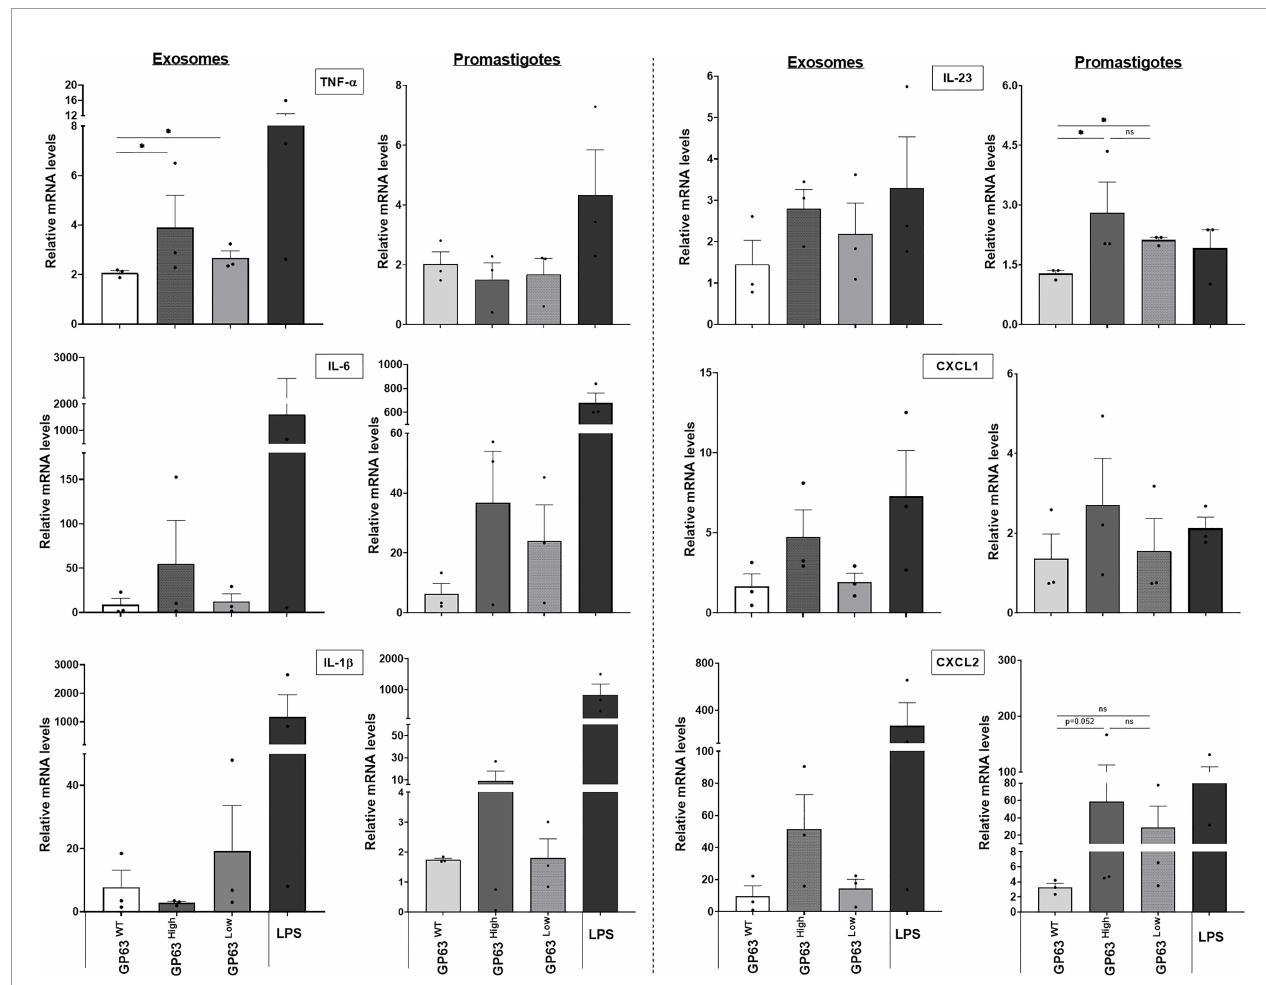
FIGURE 4 | Impact of various Leishmania amazonensis species and their derived EVs stimulation on the in fl ammatory response gene expression of innate immunity cells. Analysis by qrt-pcr of key in fl ammatory cytokines and chemokines of immortalized bone marrow-derived macrophages (B10Rs), after stimulation for 4 hours with either the 3 different populations of Leishmania amazonensis -derived EVs or the 3 strains of Leishmania amazonensis live parasites; One-way ANOVA by Kruskal-Wallis test and multiple comparisons by Uncorrected Dunn`s test; *p < 0.05. No symbol, nonsigni fi cant; Bars= Average ± SEM.